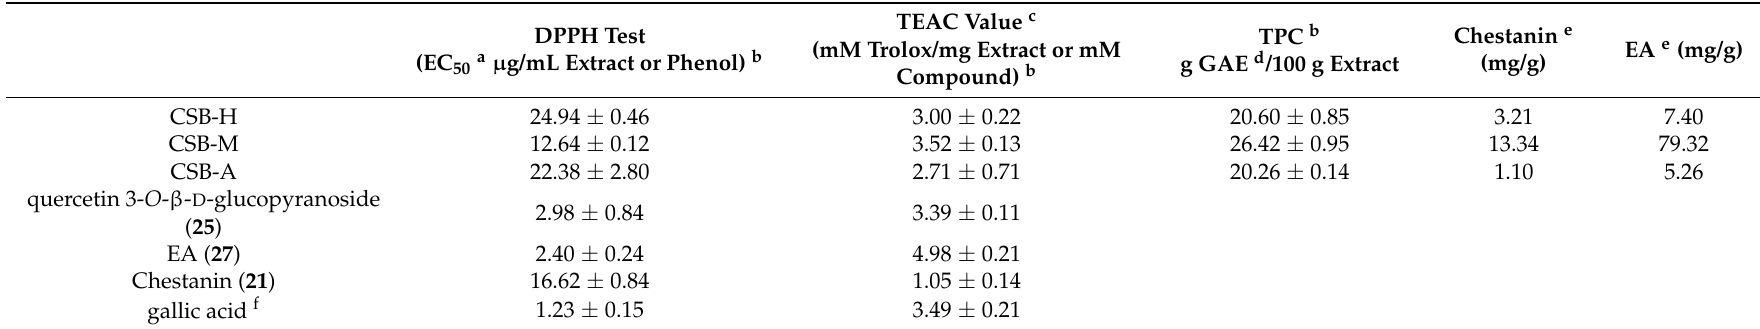
Table 1. Free radical-scavenging activity, total phenolic content (TPC), and amount of Chestanin ( 21 ) and ellagic acid (EA, 27 ) in C. sativa burs (CSB)